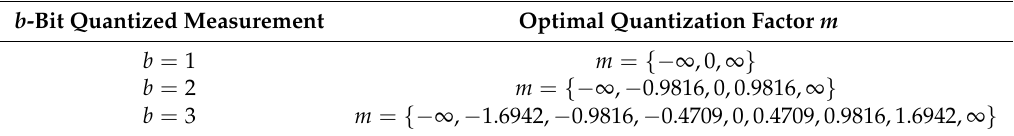
Table 1. Optimal quantization factor m for a b -bit quantized